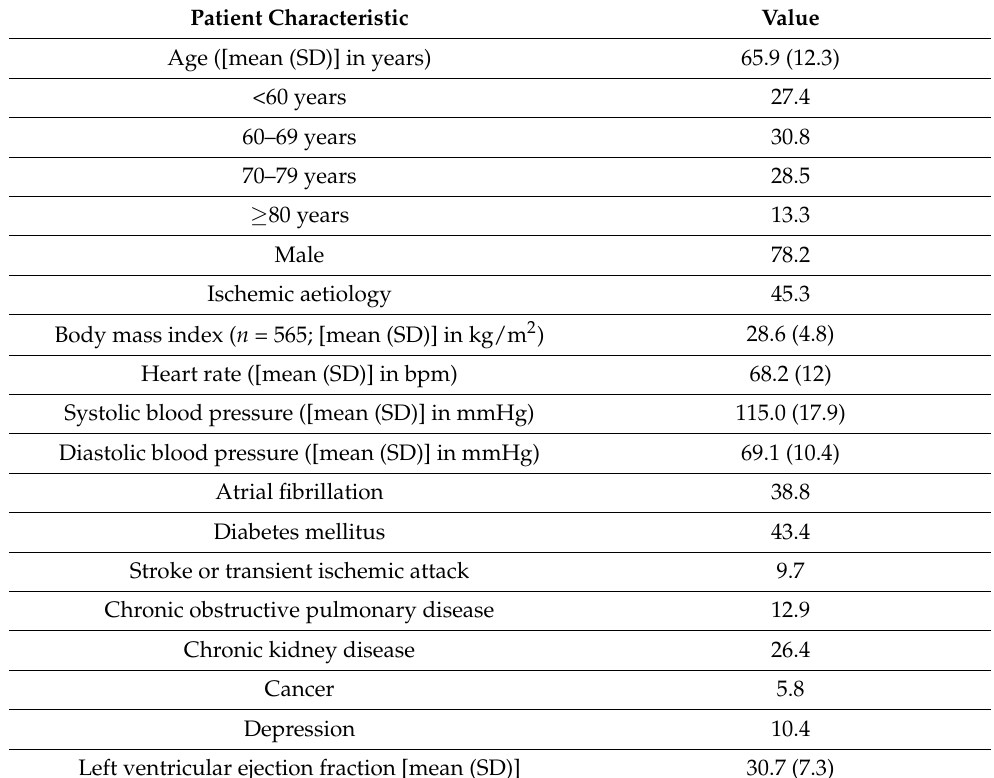
Table 1. Baseline patient characteristics at the time of